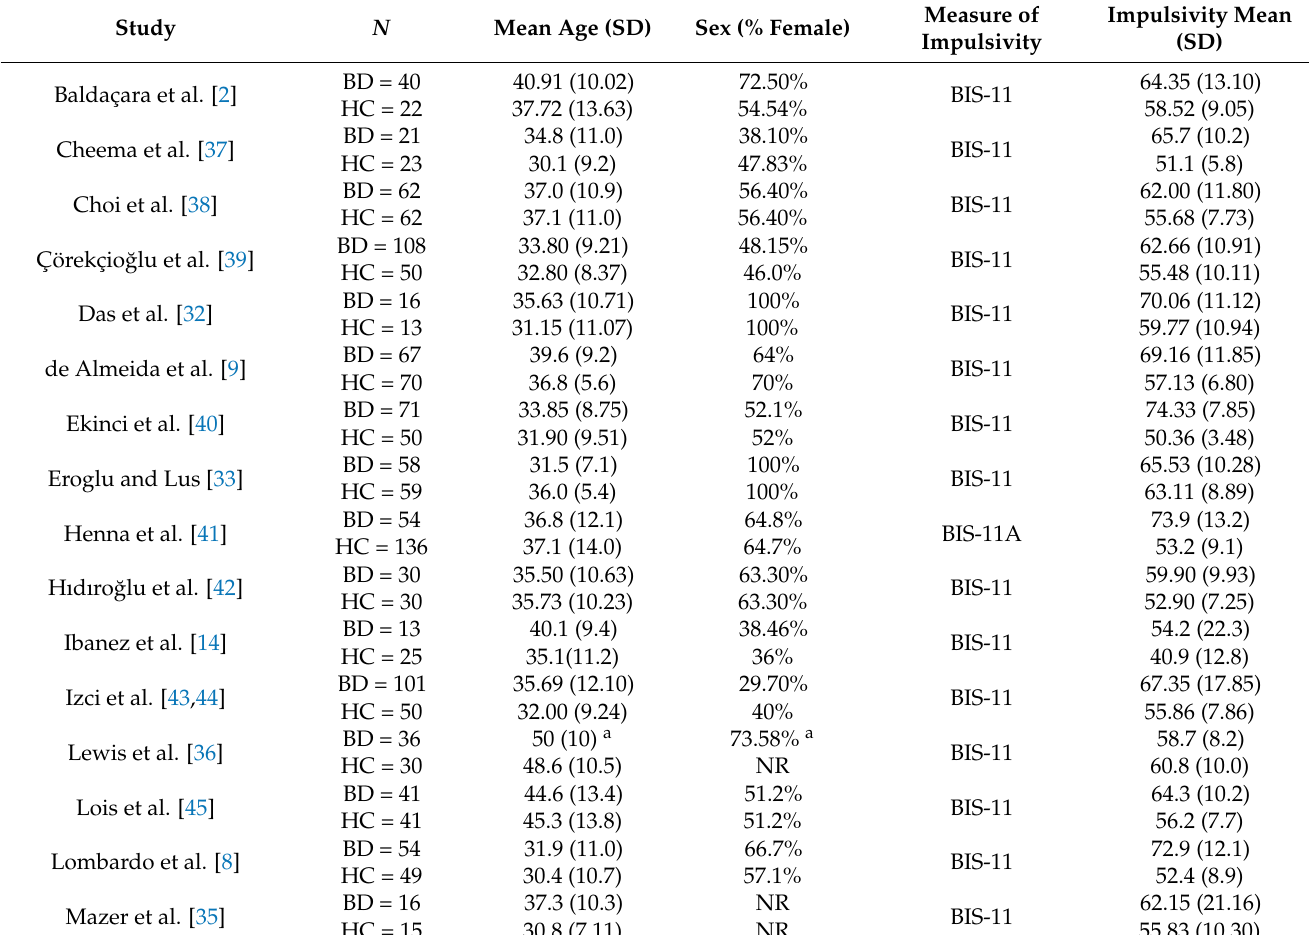
Table 1. Study characteristics of self-report impulsivity